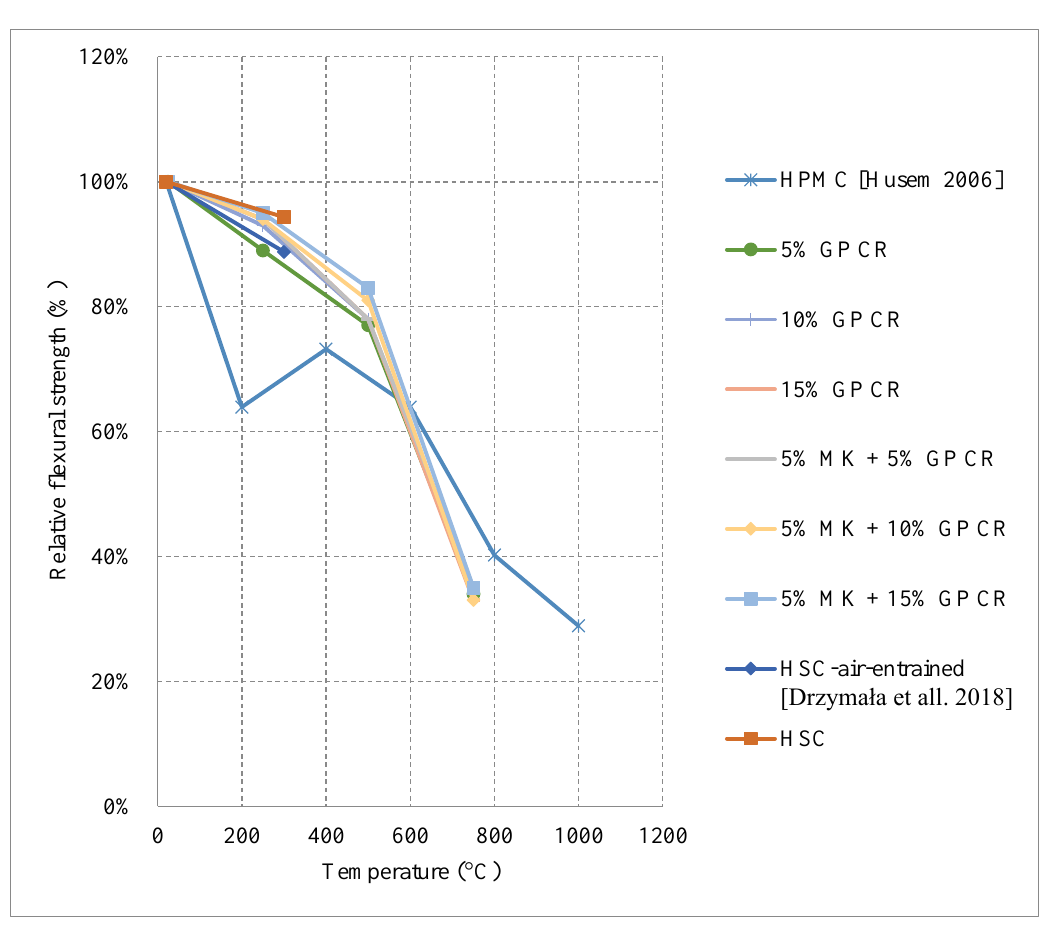
Figure 15. Relative flexural strength of naturally cooled HSC with different constituents. HPMC: Micro-High-Performance Concrete, MK: Metakaolin, GP: Ground Pumice [67,74].